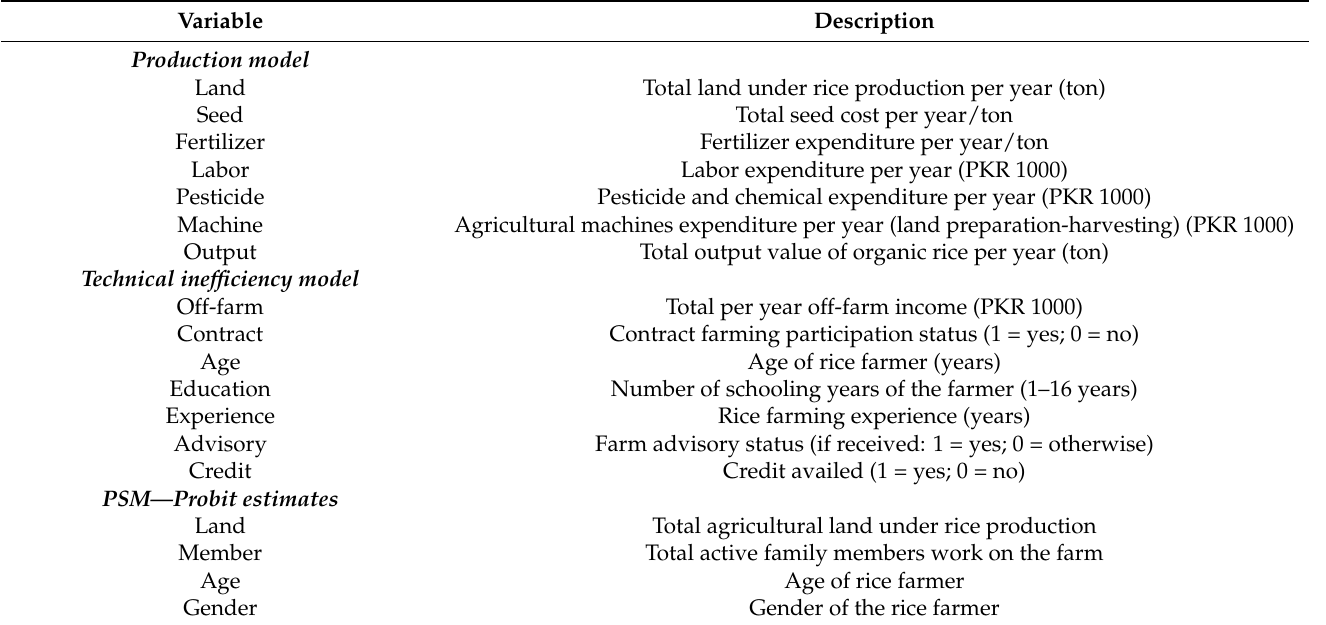
Table 1. Description of variables included in the estimation.